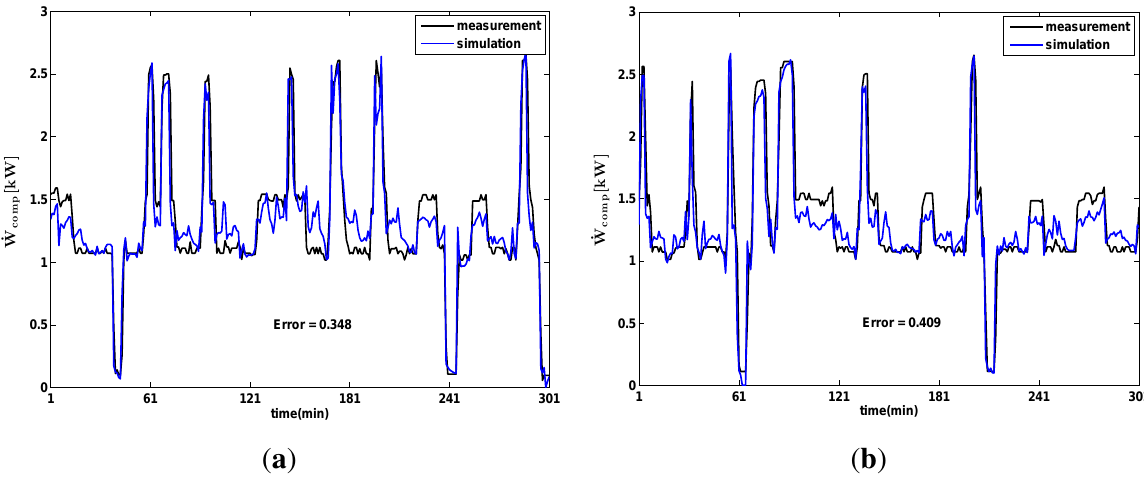
Figure 11. Power consumption estimations for low stage compressor bank of the freezing section. ( a ) Estimation using training data; ( b ) Estimation using validation data.